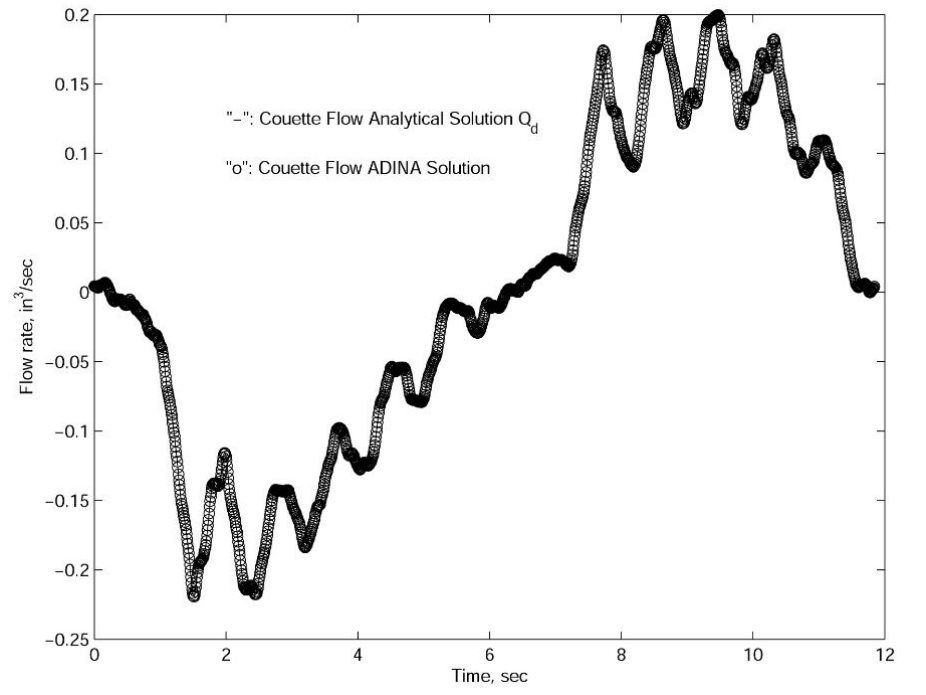
Figure 5. Quasistatic confirmation with CFD results for Couette Flow.